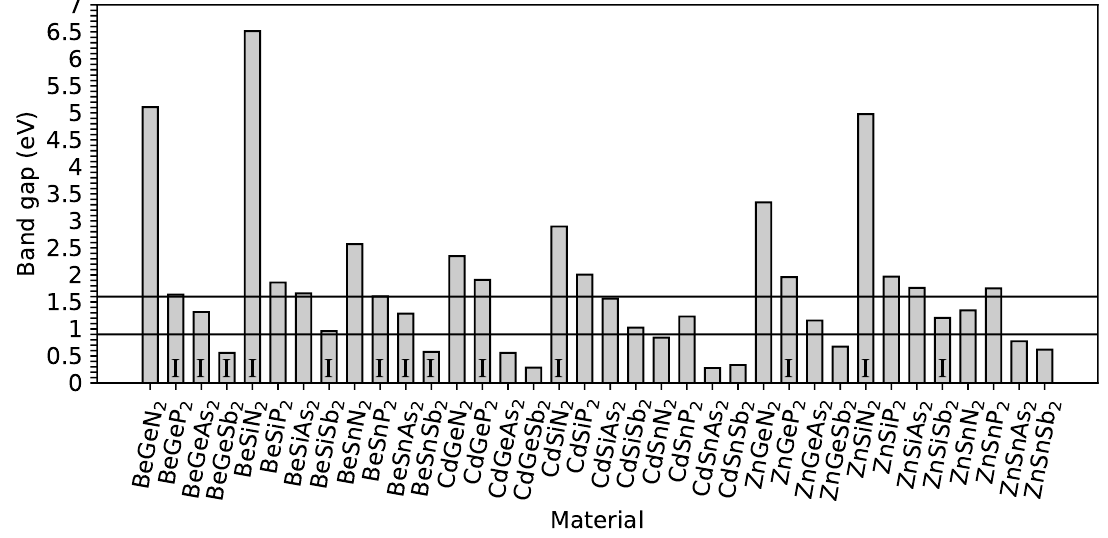
Figure 3. The calculated electronic band gap. Indirect band gap materials are denoted by I. (Color online.) The ideal materials for photovoltaic applications should have a direct band gap between 1 eV and 1.5 eV [15]. We chose materials with a direct band gap between 0.9 eV